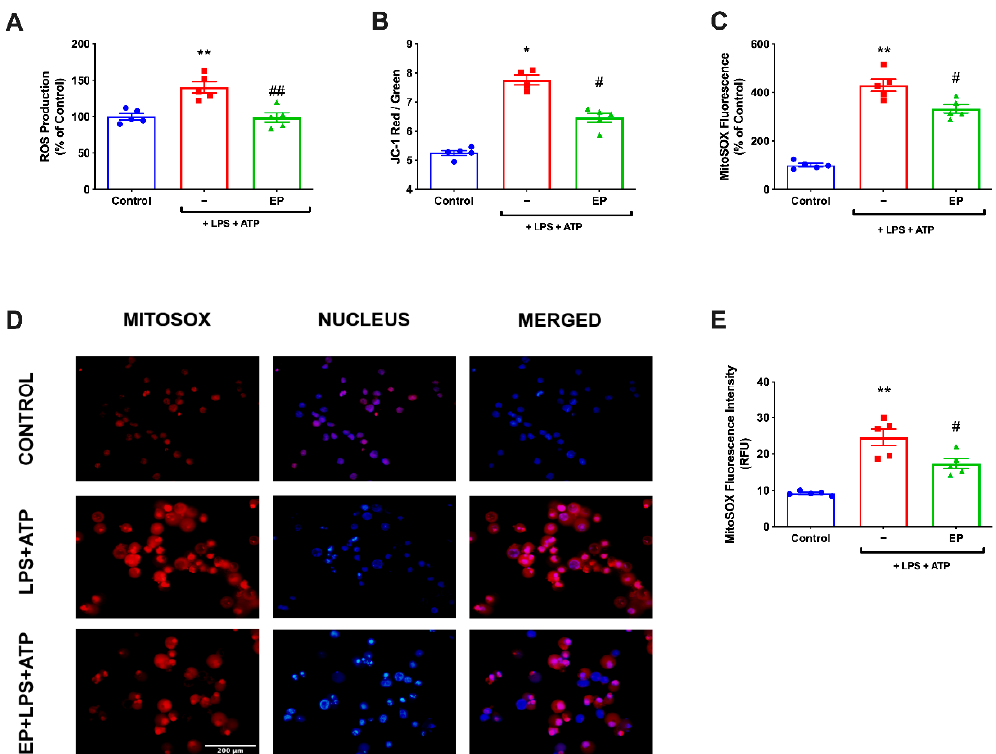
Figure 4. EP inhibited intracellular and mitochondrial ROS production and restored mitochondrial membrane potential. N9 microglial cells were pretreated with EP (10 mM) for one hour, then treated with LPS (1 µ g/mL) for four hours, and ATP (5 mM) for 1 h. ( A ) EP pre-treatment reduced intracellular ROS production. ( B,C ) EP also decreased mitochondrial ROS production in EP-pretreated cells compared with LPS- and ATP-induced cells. ( D,E ) EP pre-treatment restored mitochondrial membrane potential. Data are presented as mean ± S.E.M, n = 5. * p < 0.05, ** p < 0.01 compared to control; # p < 0.05 compared to LPS- and ATP-induced cells and ## p < 0.01 compared to LPS- and ATP-induced cells.